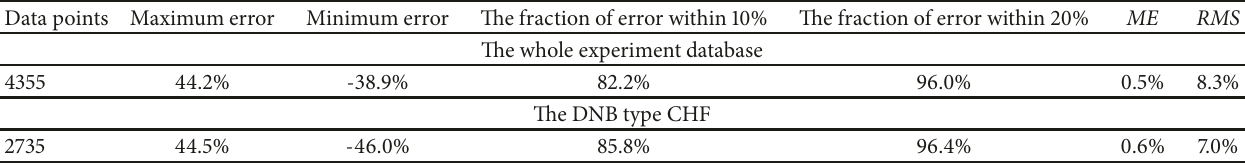
Table 5: Prediction error of the present mechanistic model.